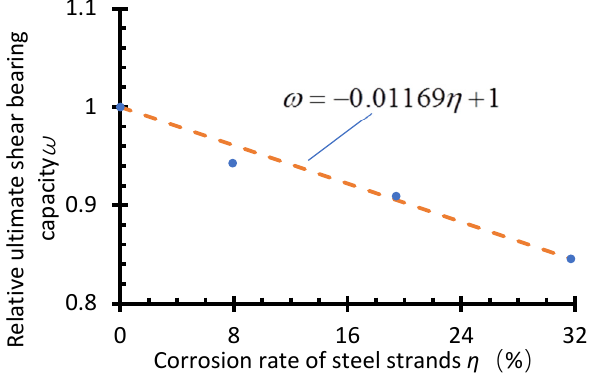
Figure 6. ω - η curves.